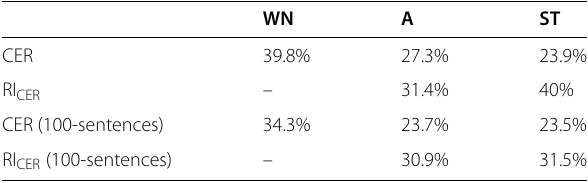
Table 6 Results of the style modification process in cases of evaluation done using Google cloud service